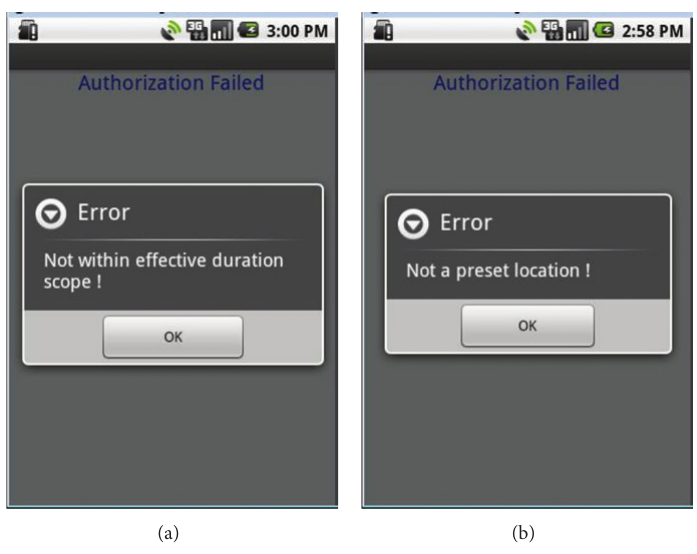
Figure 7: Examples of authorization failure.